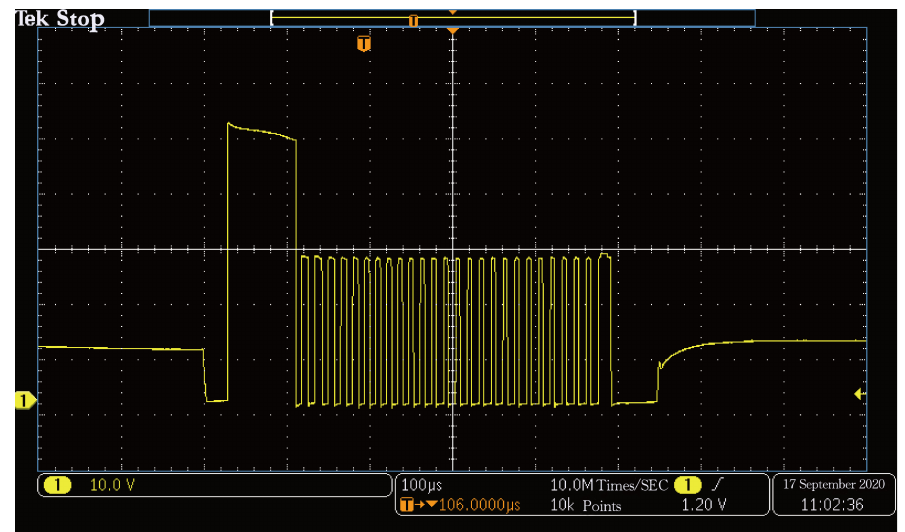
Figure 24. Injection pulse signal